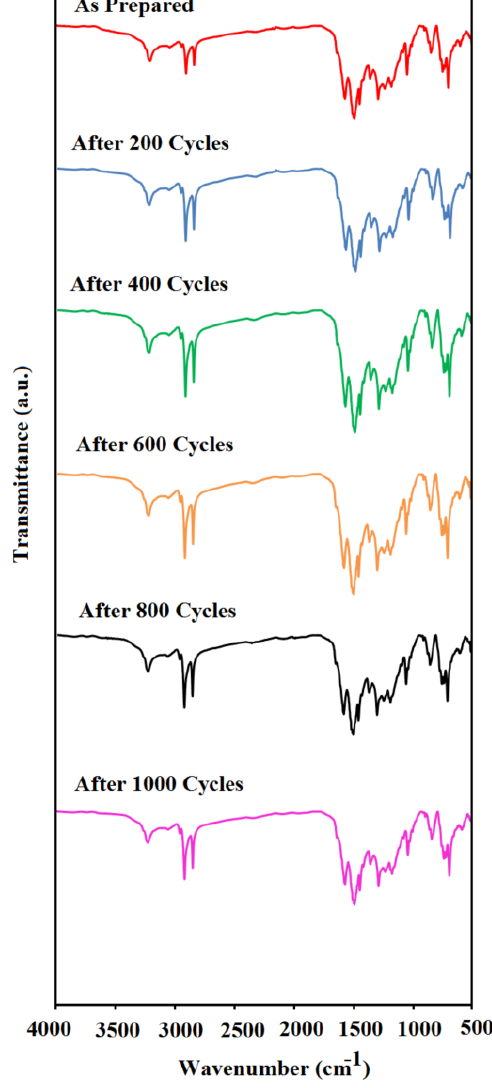
Figure 6. Structure stability of microencapsulated S1 after different cycling